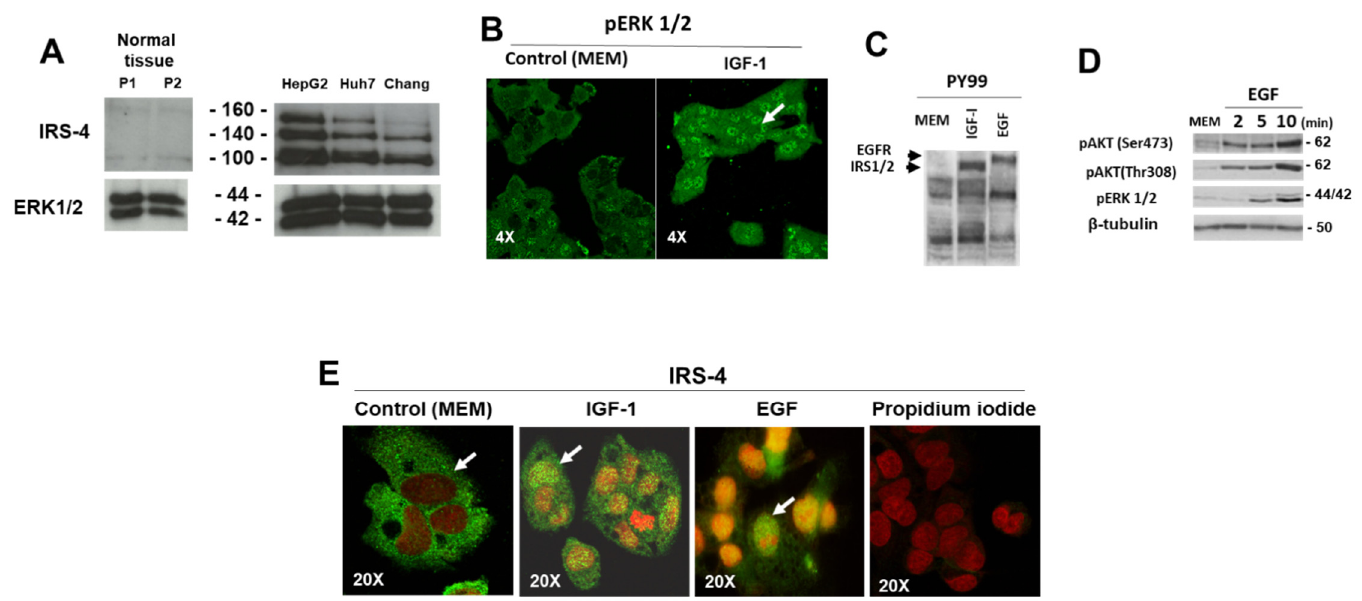
Figure 5. Study of IRS-4 and cell cycle-related proteins using immunostaining and immunoblotting techniques. ( A ). Western blot analysis of IRS-4 expression in normal liver biopsies of two patients and in HepG2, Huh7, and Chang cells. ERK 1/2 was used as loading control. This experiment is representative of three others with similar results. ( B) . HepG2 cells treated with IGF-1 and stained with anti-pERK1/2 antibody (green). ( C ). Western blot analysis of tyrosine phosphorylation following either IGF-1 or EGF stimulation. ( D ). Time course studies of phosphorylation after EGF stimulation. ( E ). HepG2 cells stained with anti-IRS-4 antibody (green) and with propidium iodine (red). For negative control, the anti-IRS-4 antibody was omitted and was incubated only with propidium iodine. The experiments shown in panels ( B – E ) are representative of three–five others with similar results.